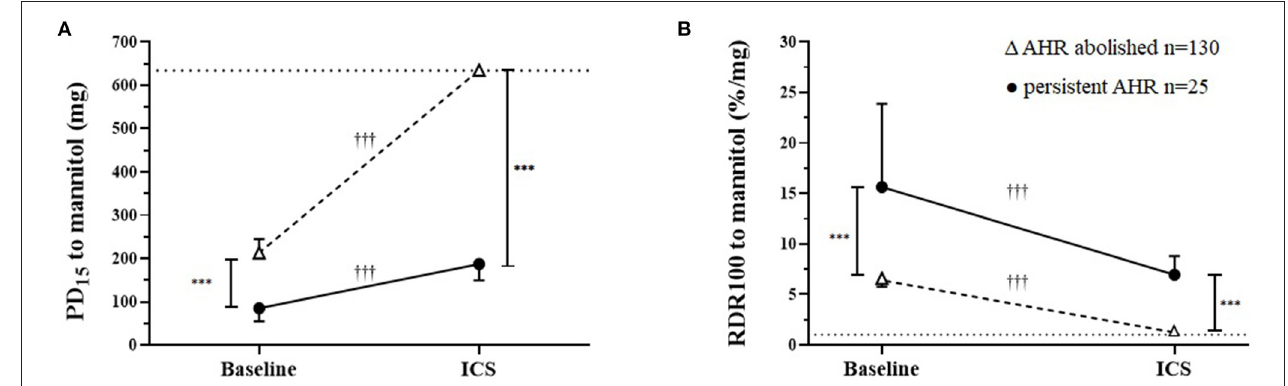
FIGURE 1 | Airway sensitivity and reactivity to mannitol at baseline and after a mean of 20 weeks daily inhaled corticosteroids (ICS) in those where airway hyperresponsiveness (AHR) was either abolished or was persistent. (A) Cumulative inhaled provoking dose of mannitol to cause 15% fall in FEV 1 (PD 15 ) baseline and follow-up ICS treatment geometric mean and 95% CI. The dotted horizontal line represents the total cumulative dose (635mg) the upper limit indicating the mildest AHR. (B) Baseline and follow-up ICS treatment for response dose ratio (RDR 100 ) geometric mean and 95% CI. The dashed line represents the mean response for † healthy non-asthmatics who do not have AHR to mannitol. Within/ * Between group differences P -value: < 0.05 * † , < 0.1 ** †† , < 0.001 *** ††† .